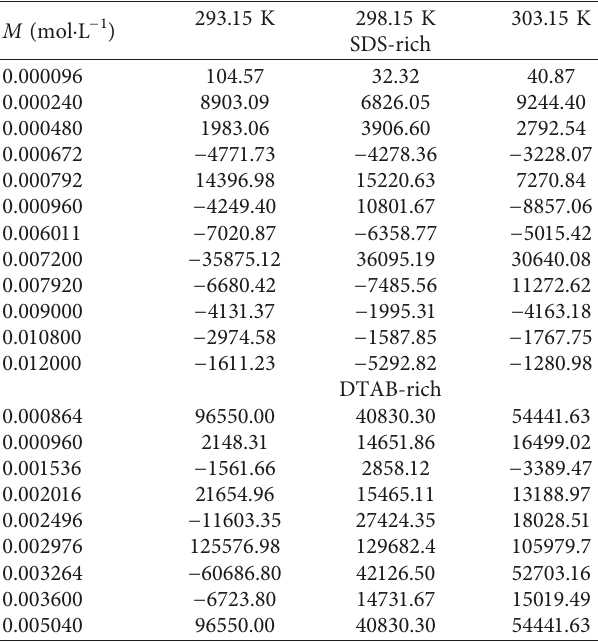
Table 5: Surface excess concentration ( Γ and DTAB-rich surfactants in the aqueous medium at the three different temperatures T � 293.15, 298.15, and 303.15K and at 0.1MPa.